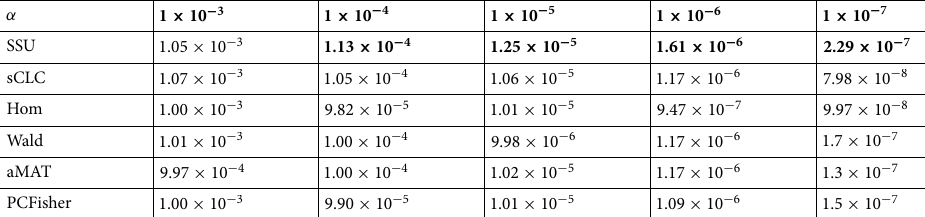
Table 1. The estimated Type I error rates at different significance levels for the six methods with the phenotypic correlation structure for the 70 phenotypes. The bold-faced values indicate that the type I error rates cannot be